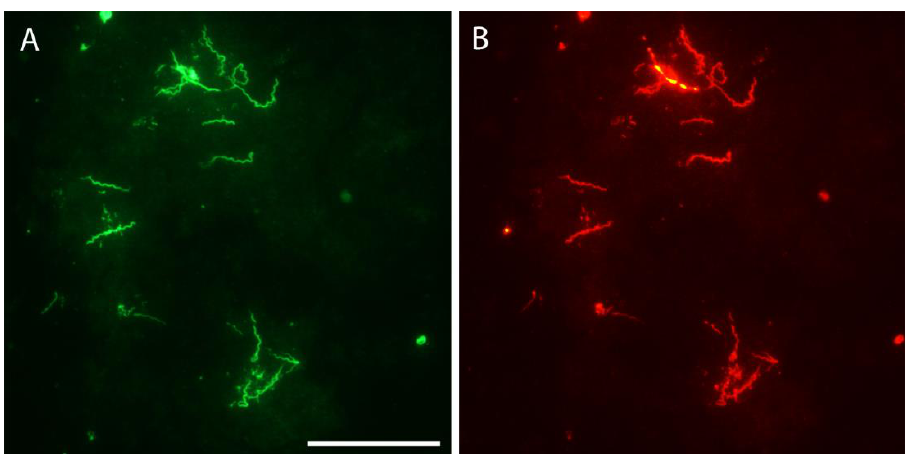
Figure 3. Borrelia hemsii aggregates in four eggs (Panels A – D ) from O. hermsi female F-1F (Table 5) stained with anti- B. hermsii rabbit hyperimmune serum and goat anti-rabbit FITC. Scale bar = 40 µm.